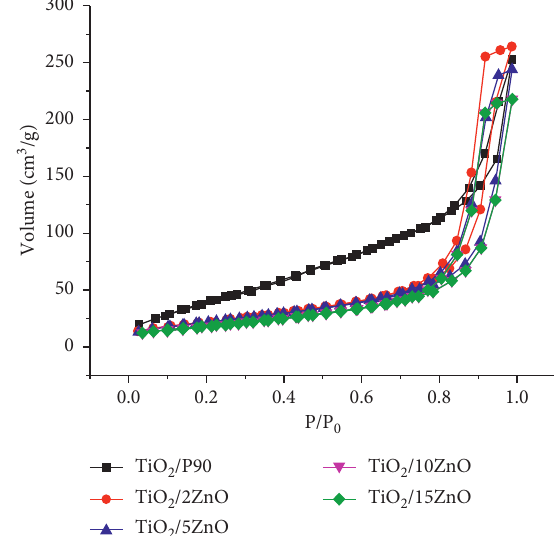
Figure 3: Nitrogen adsorption-desorption isotherms of TiO